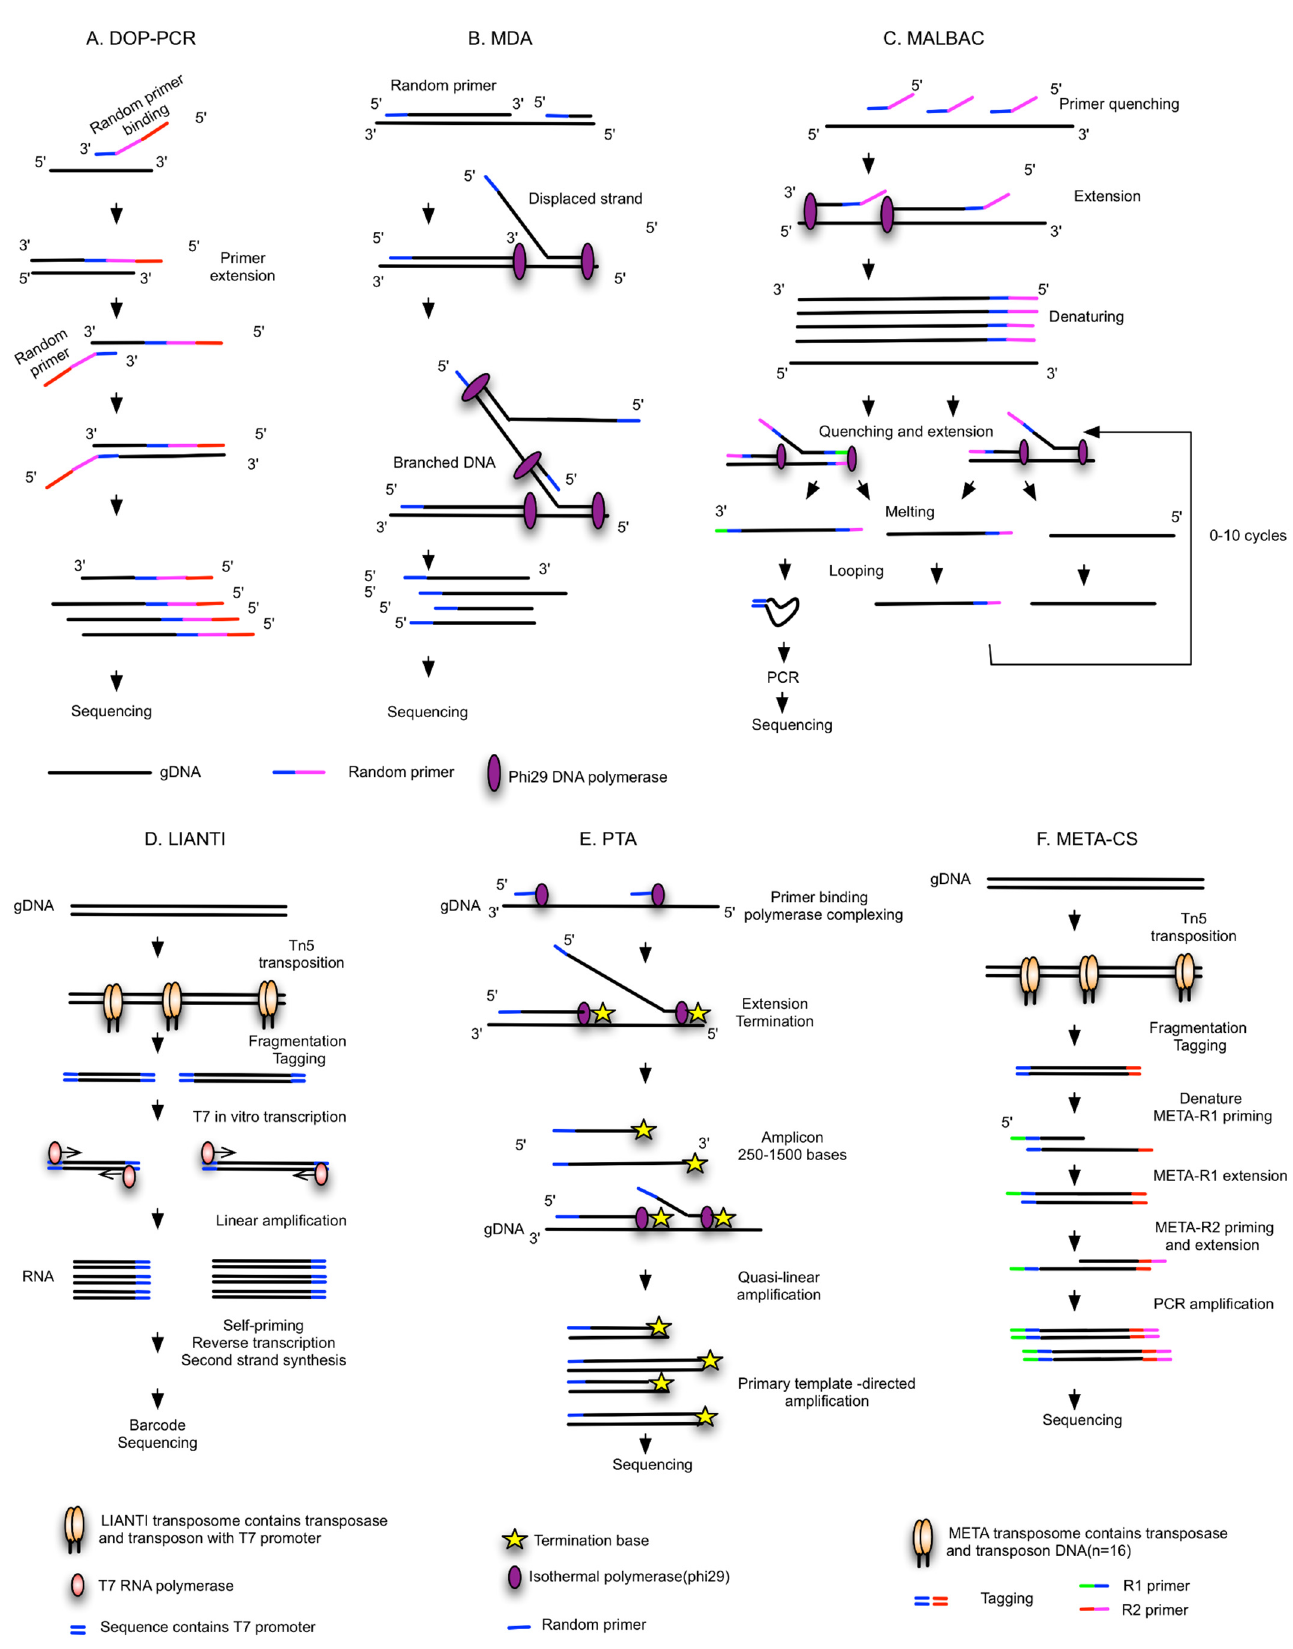
Figure 2. Different WGA principles. The schematic workflows are simplified and adapted from [33,39,41]. ( A ) Degenerate oligonucleotide-primed PCR (DOP-PCR): random priming with degen- erate oligonucleotide primers (DOPs) and PCR. ( B ) Multiple displacement amplification (MDA): random priming and isothermal amplification with phi29 DNA polymerase, with strong strand dis- placement activity. ( C ) Multiple annealing and looping-based amplification cycles (MALBAC) in- volve random primers with fixed sequences for the amplification of linearly original gDNA to form semi-amplicons, and full amplicons are further amplified and form DNA loops attributable to the complementary sequences at 5’ and 3’ ends. DNA loops are PCR-amplified. ( D ) Linear amplification via transposon insertion (LIANTI) uses gDNA fragmented by the Tn5 transposome and tagged with sequences containing the T7 promoter. T7 RNA polymerase binds the promoter and linearly ampli- fied RNA, and cDNA is generated by reverse transcription and further tagged with barcodes for sequencing. ( E ) Primary template-directed amplification (PTA) utilizes phi29 polymerase and exo- nuclease-resistant terminators to create small double-stranded amplicons that undergo limited quasilinear processes, with more amplifications occurring based on the primary template. ( F ) Multiplexed end-tagging amplification of complementary strands (META-CS) works via transpo- some complexes that form from a 1:1 molar ratio of Tn5 transposase and a mixture of 16 unique transposons, which allows DNA fragmentation and tagging with two random transposon se- quences. Forward and reverse strands of original DNA are pre-amplified to obtain strand-specific labelling.